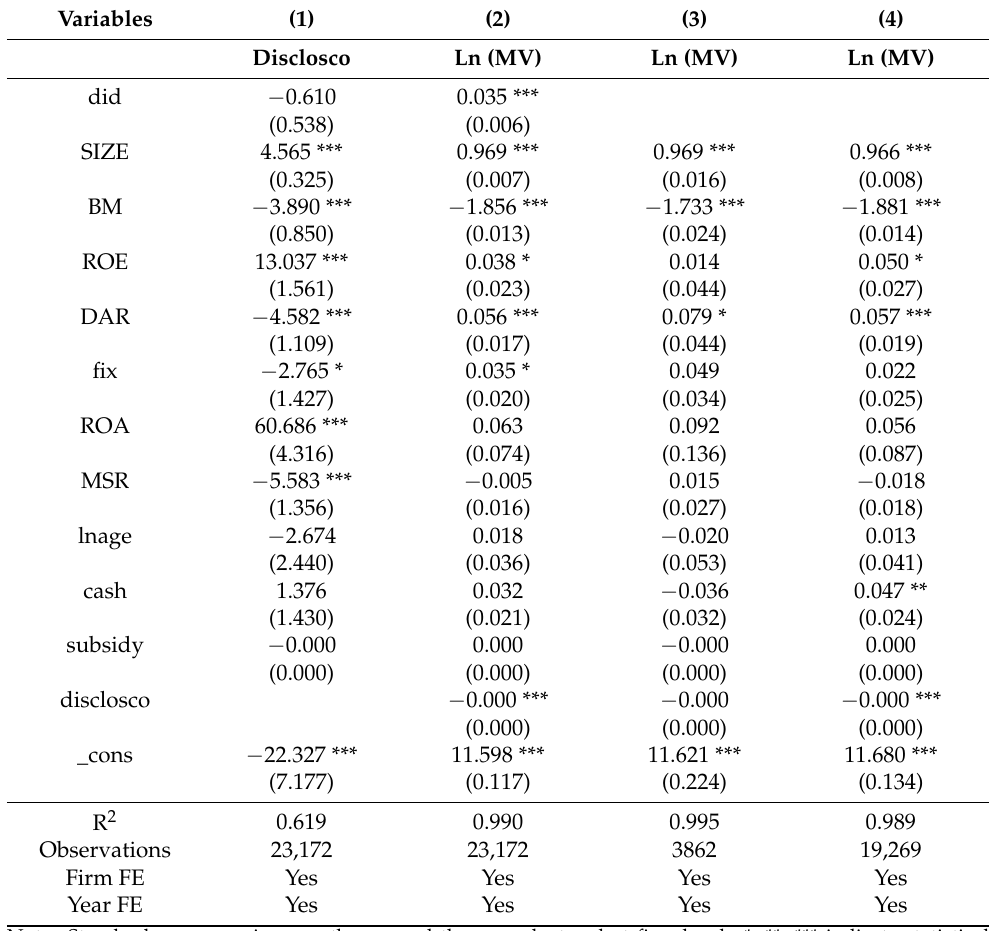
Table 8. Regression results of mediation mechanism analysis based on carbon